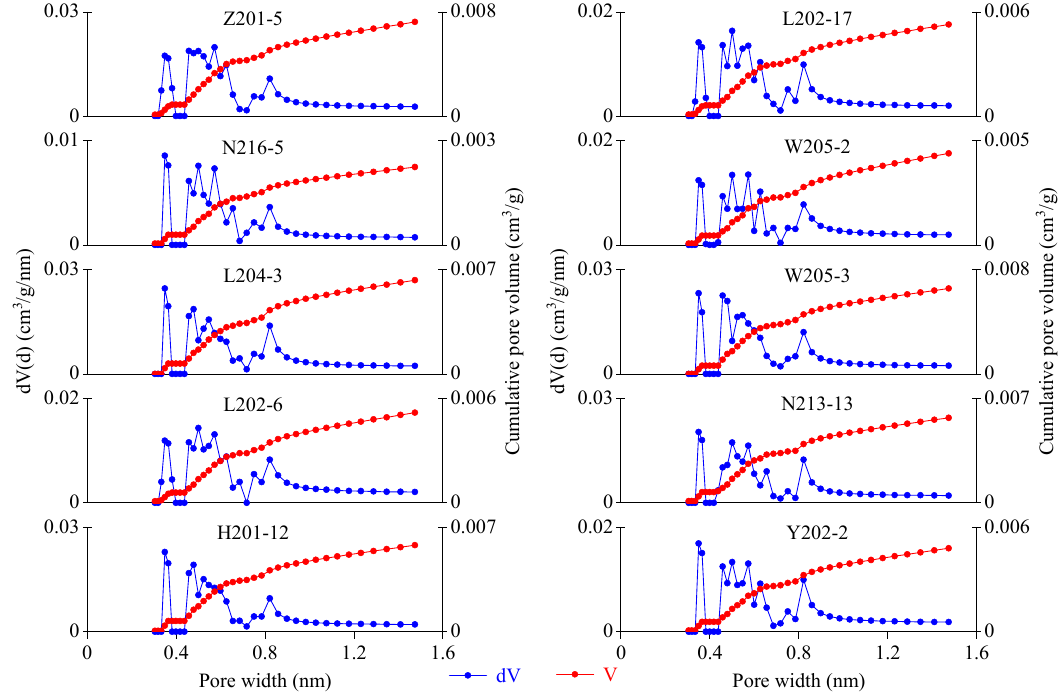
Figure 8. Pore size distribution curves from low ‐ pressure CO 2 adsorption experiment.